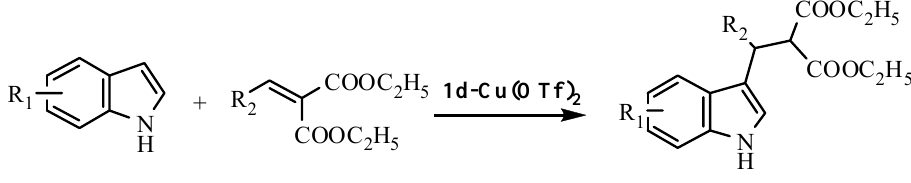
Table 2. 1d -Cu(OTf) catalyzed Friedel-Crafts reaction of indole derivatives with 2 alkylidene malonates.